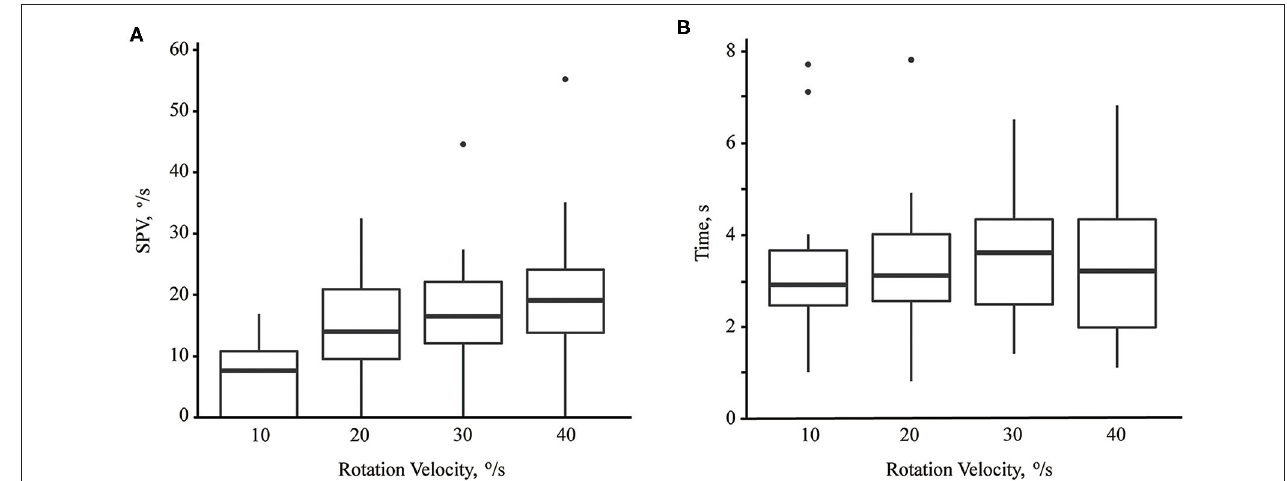
FIGURE 4 | The maximum slow phase velocity (SPV, A ) and time constant (B) of paroxysmal downbeat nystagmus induced during motorized rotation chair test at four different rotation velocities. As the rotation velocity was escalated from 10 to 40 ◦ /s, the maximum slow phase velocity of induced downbeat nystagmus increased while the time constant remained